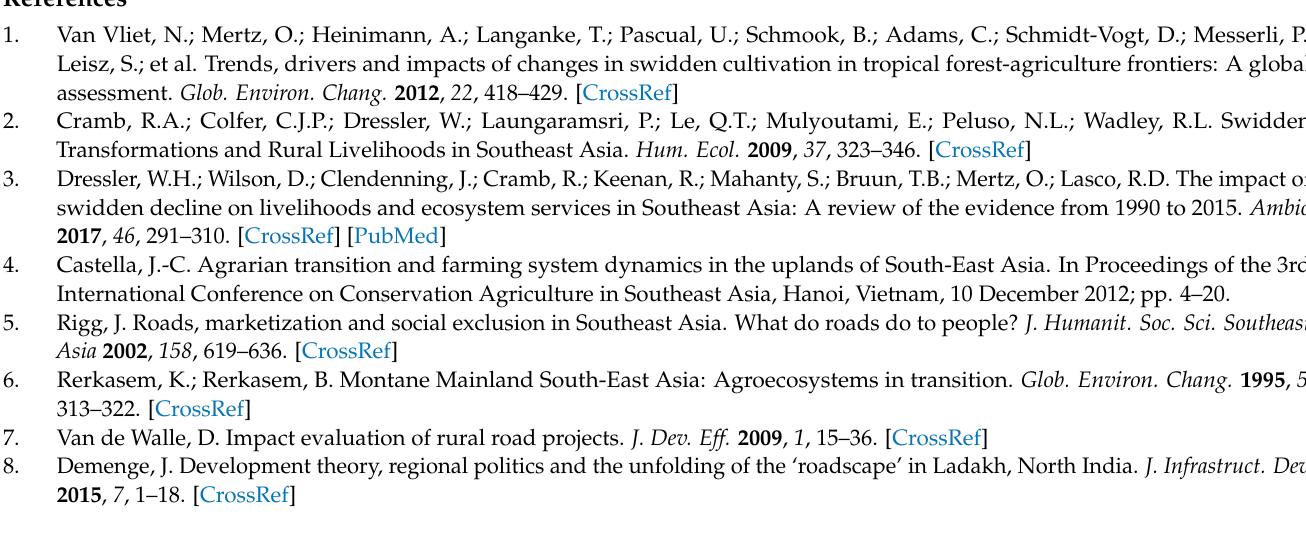
Figure A4. Game sessions conducted in different villages.